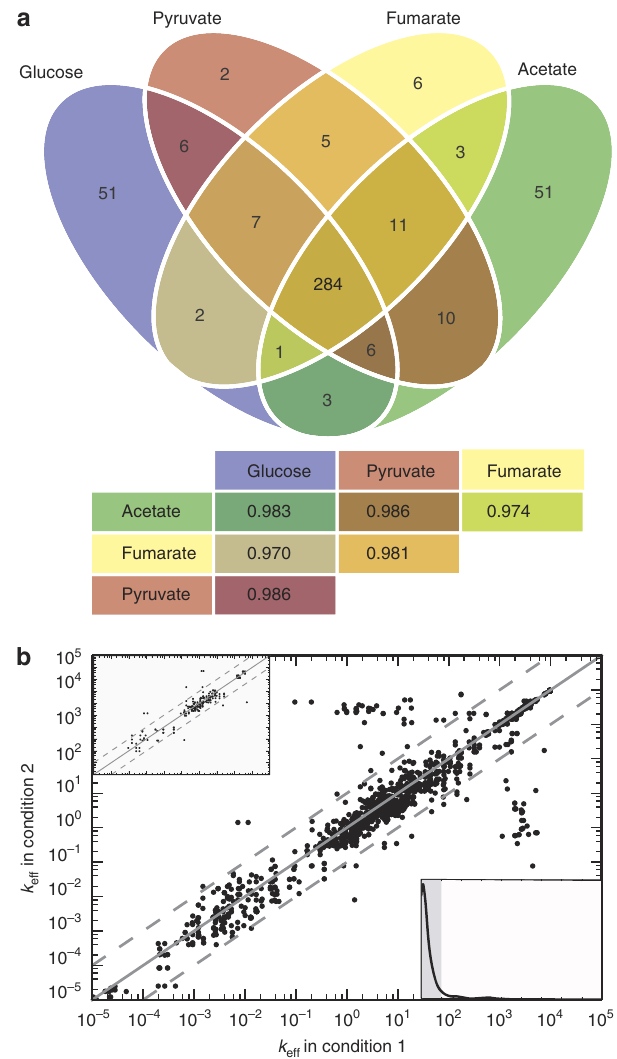
Figure 4 | Effective enzyme turnover rates ( k eff ) as regularities emerging from coupling quantitative in vivo proteomic data with genome scale modelling. ( a ) Venn diagram of calculated turnover rates shows all four conditions share 90% of the same estimates (Pearson’s correlations below). ( b ) Pairwise comparisons across four conditions for calculated turnover rate parameters demonstrate 94% are within one order of magnitude. The upper inset show the parameter estimation for the 10% most variable components of the proteome between the four conditions examined. The lower inset show a histogram of the distances of every point from the diagonal line. The grey box contains the 94% of the values that deviate from one another within an order of magnitude. A more detailed version is found in Supplementary Fig.